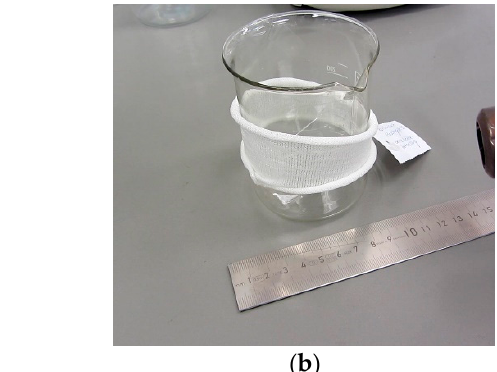
Table S1: Mechanical properties, Table S2: Thermal properties, Table S3: Shape memory properties, Table S4: Force before and after stimulation at di ff erent constant strains for yarn samples with and without pre-strain fixation, Figure S1: Force before and after stimulation at di ff erent constant strains for yarn samples with and without pre-strain fixation. Figure S2: Stress-strain curve of a TPU / PCL blend 70 / 30 yarn sample without stimulation. Video S1: A knitted tube comprised of a shape memory blend yarn in widened state shrinking due to heat